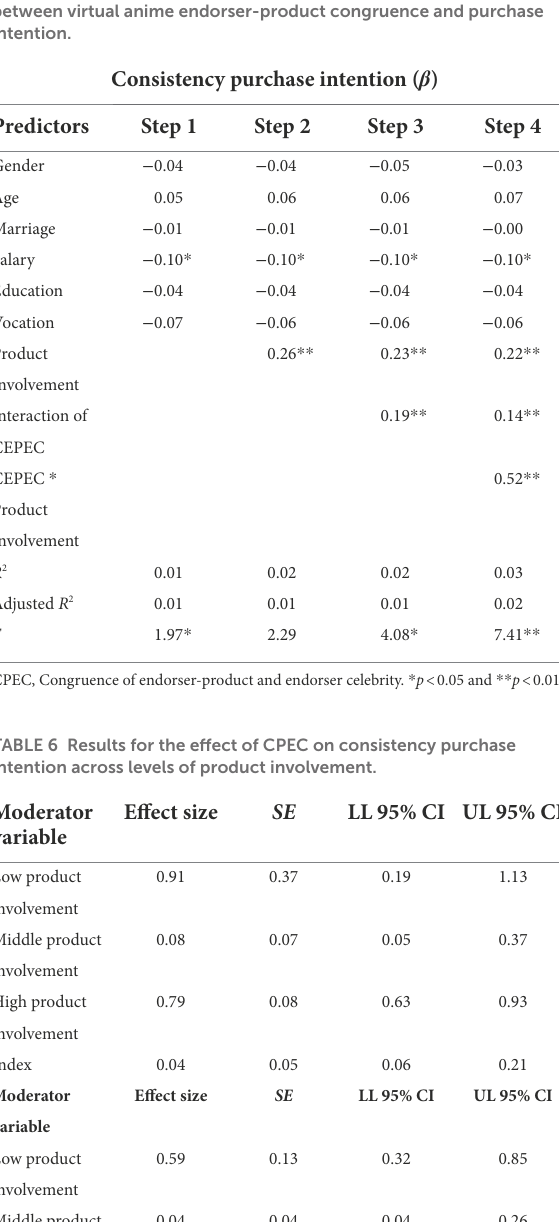
TABLE 5 Results of product involvement as a moderating role between virtual anime endorser-product congruence and purchase intention.